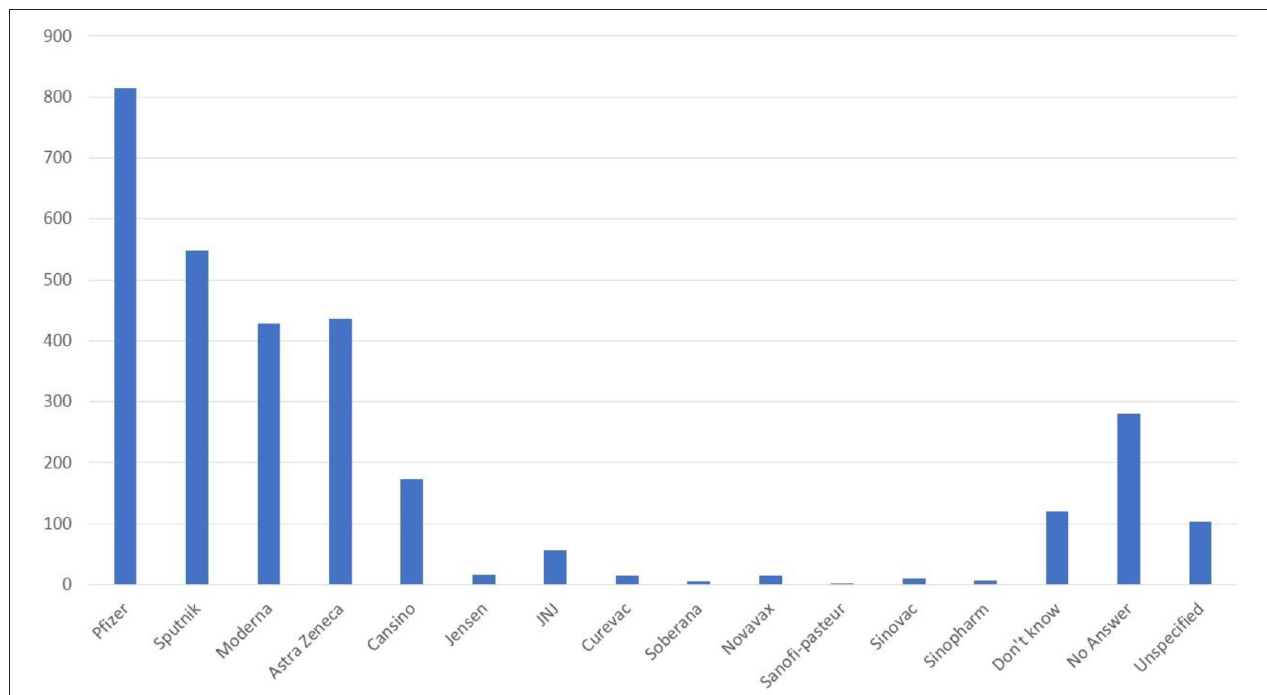
FIGURE 1 | Frequency counts as the most researched coronavirus disease 2019 (COVID-19) vaccines